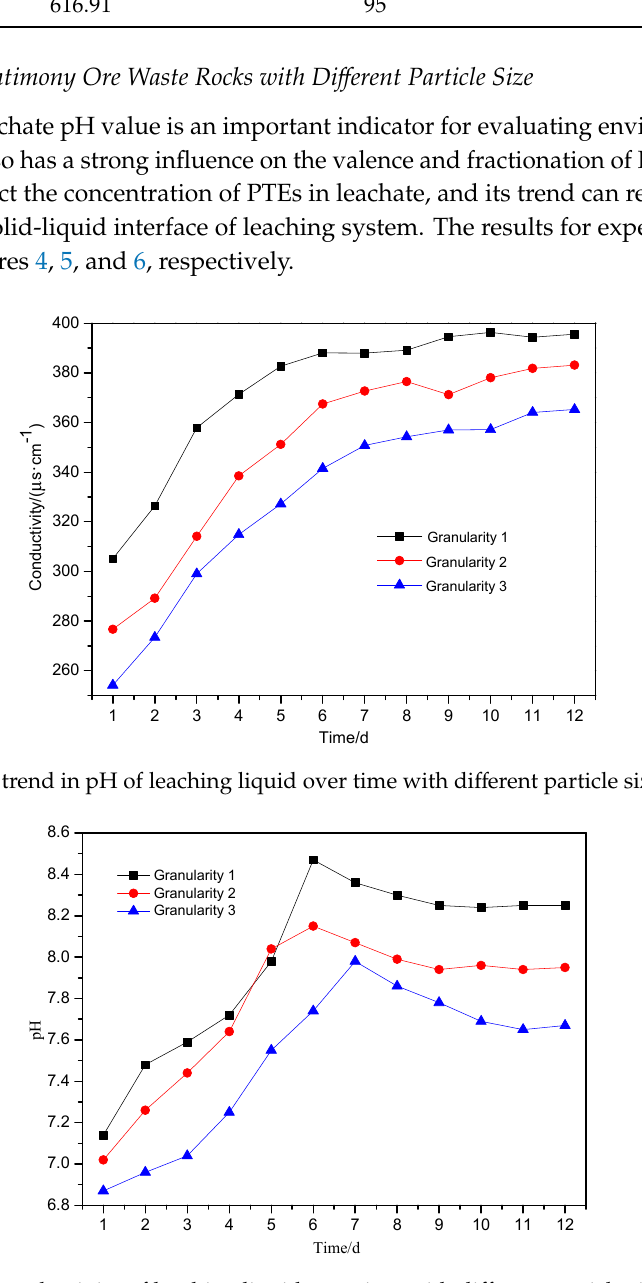
Figure 5. The conductivity of leaching liquid over time with different particle size of waste.